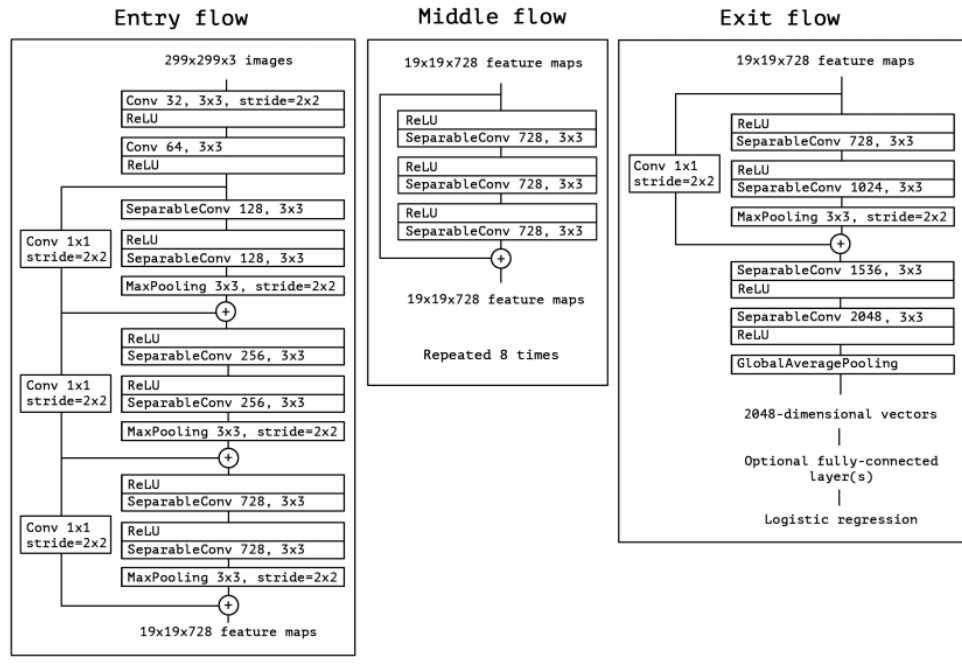
Figure A2. The architecture of Xception [33].